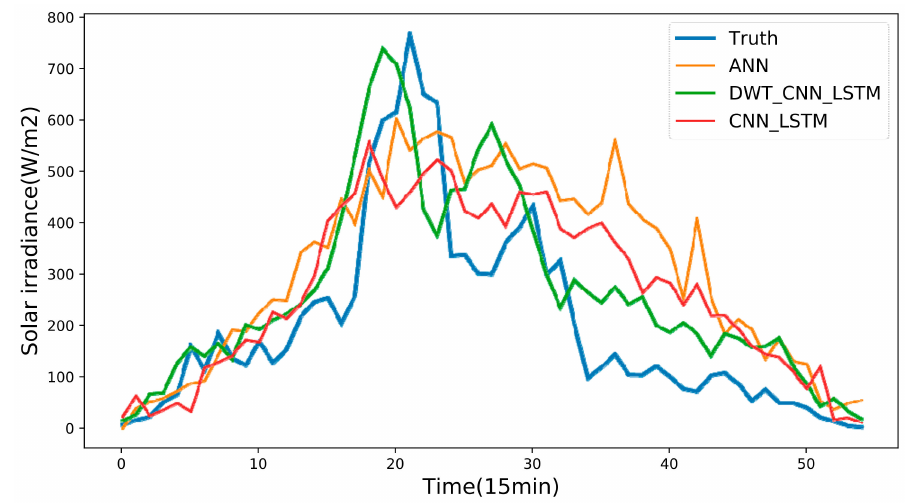
Figure 9. Actual and forecasted solar irradiance on rainy day pattern using dataset of Elizabeth City State University.